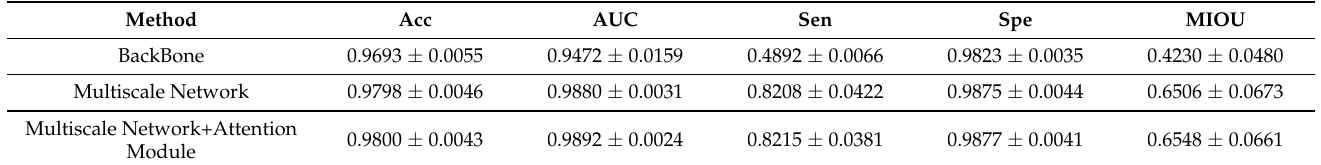
Table 4. The performance for each part of the CHASEDB1 dataset inside